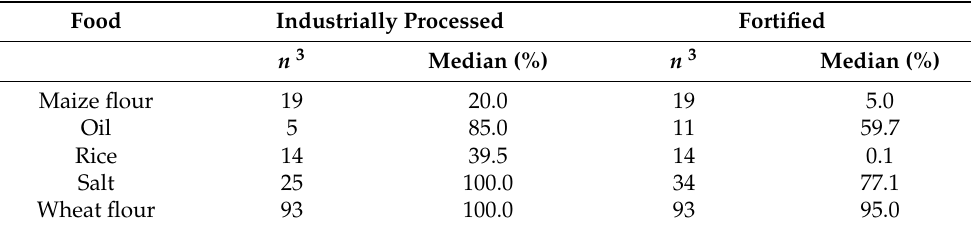
Table 4. The percentage of foods industrially processed 1 and the percentage of foods fortified 2 in countries with these data (GFDx